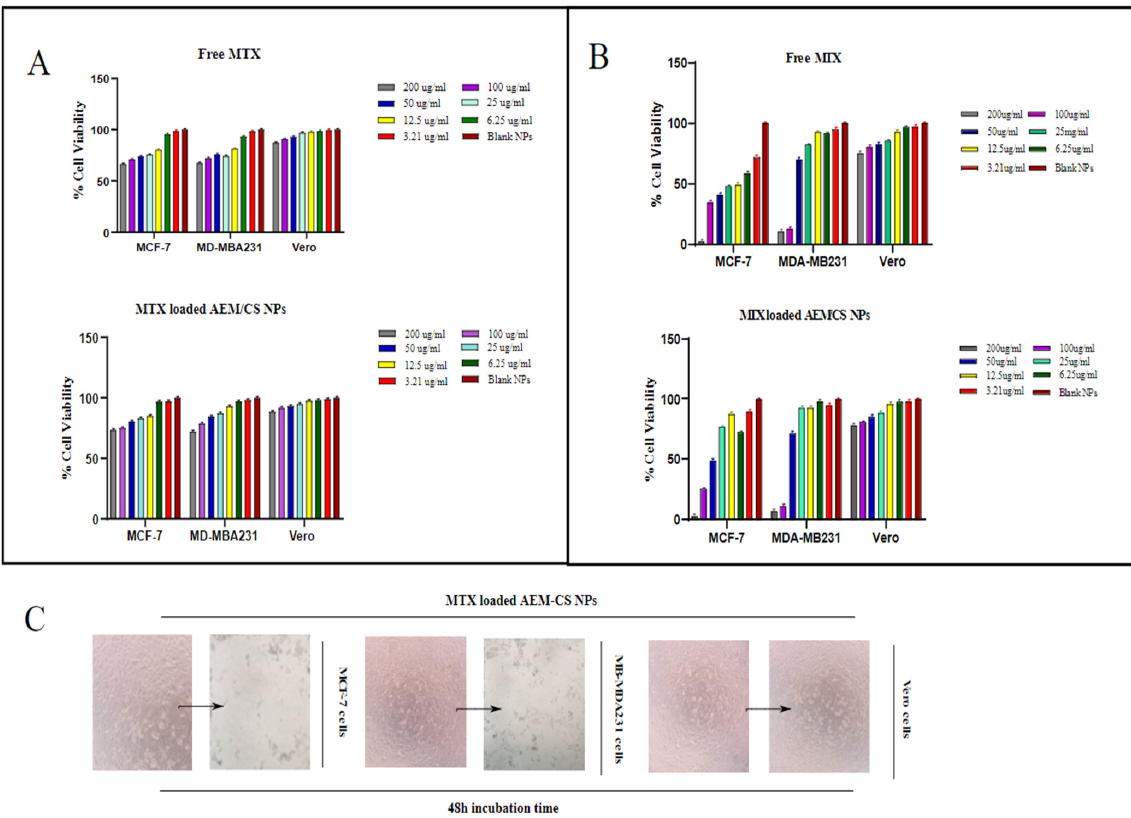
Figure 6. Quantitative cytotoxicity analysis of free MTX and MTX loaded AE/CS NPs (F2) on MCF-7, MDA-MB231 cancer cells and Vero (normal cells) after ( A ) 24 h, ( B ) 48 h treatment duration with DMSO and Blank AEM-CS NPs (no drug) as control, ( C ) Representative images of MCF-7, MDA- MB231 cancer cells and Vero (normal cells) upon treatment with F2 formulation (Scale bar = 1 mm). Data are presented as Mean ± S.D; p < 0.001.